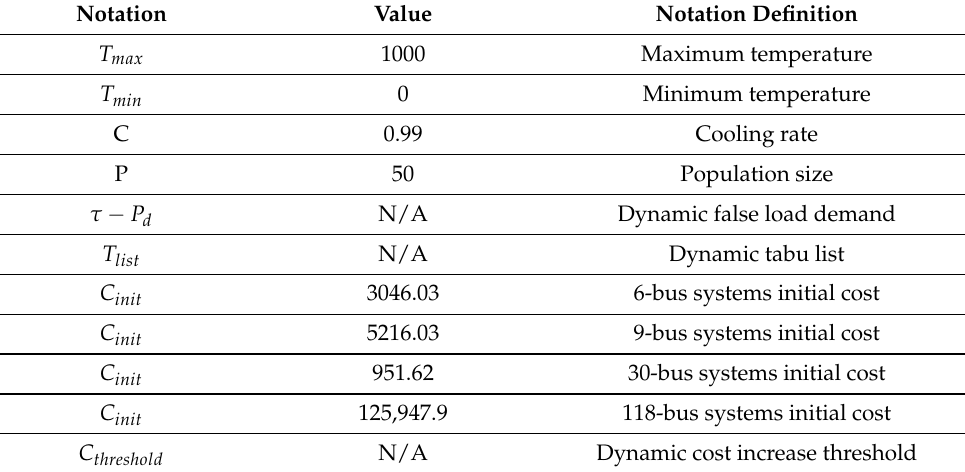
Table 4. Simulation